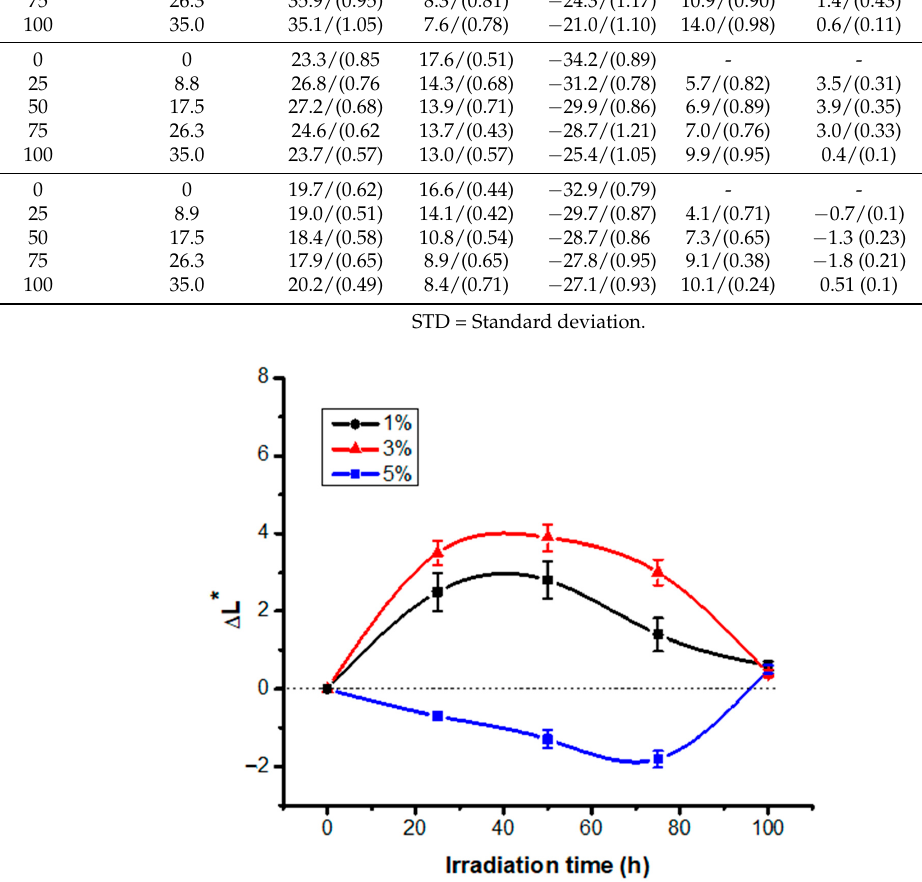
Figure 1. Δ L* variation recorded for RB_204 samples during irradiation. Figure 1. ∆ L* variation recorded for RB_204 samples during